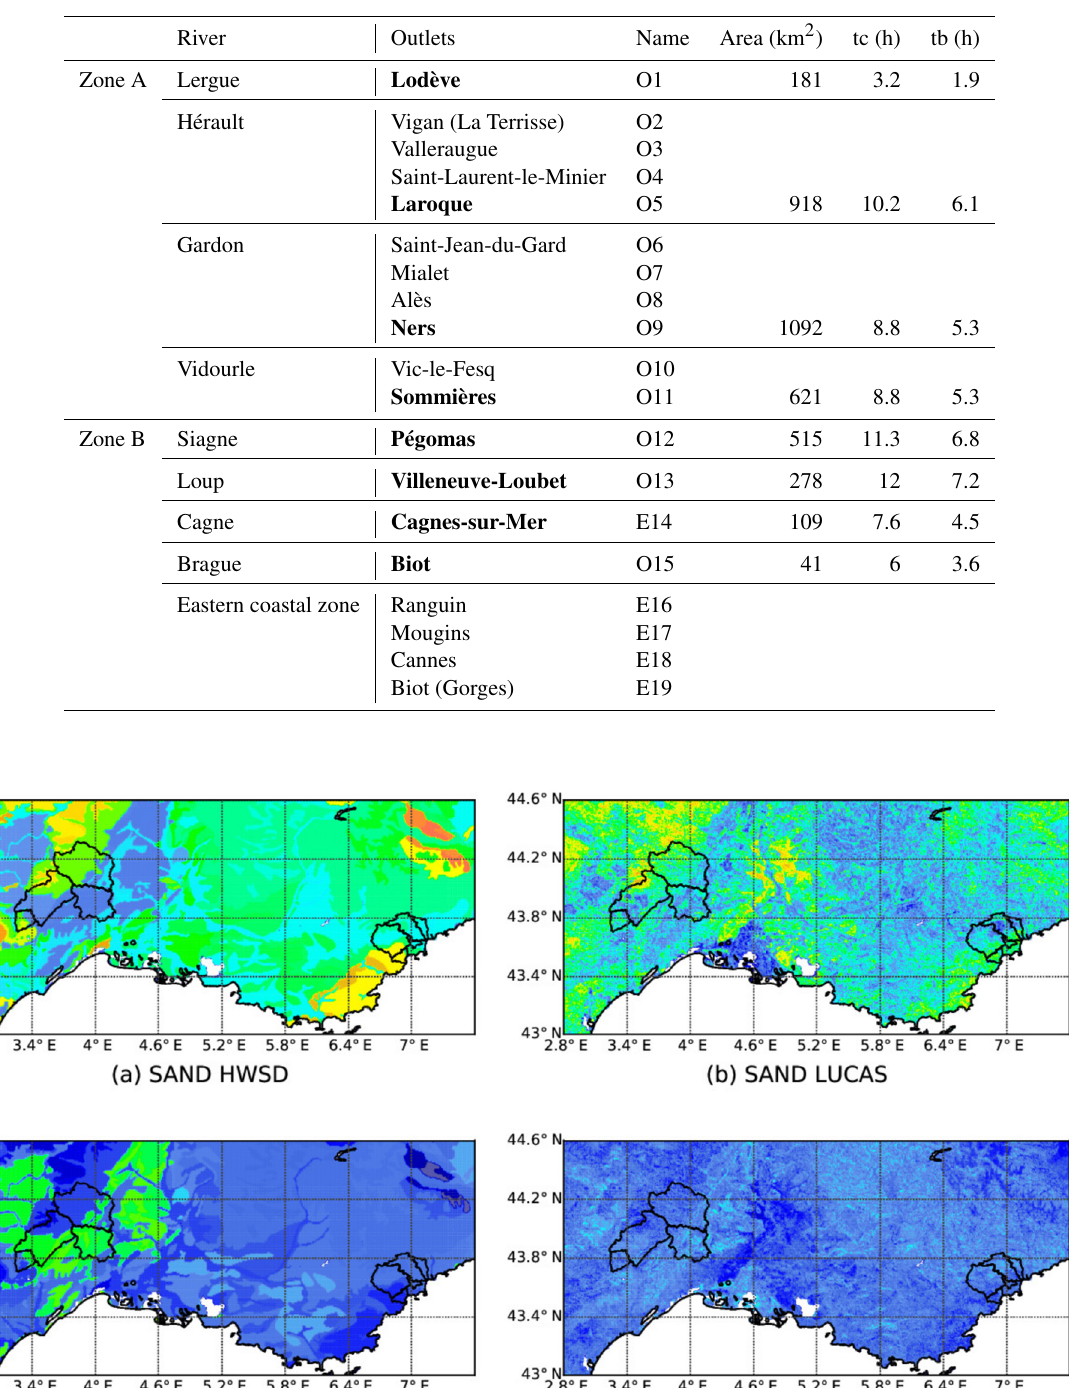
Table 1. Characteristics of the main studied catchments and outlets. Their locations are given in Fig. 1 from west to east within each catch- ment. The basin characteristic times, presented in Appendix A, are reported here. The names of the outlets of the main studied catchments are in bold.